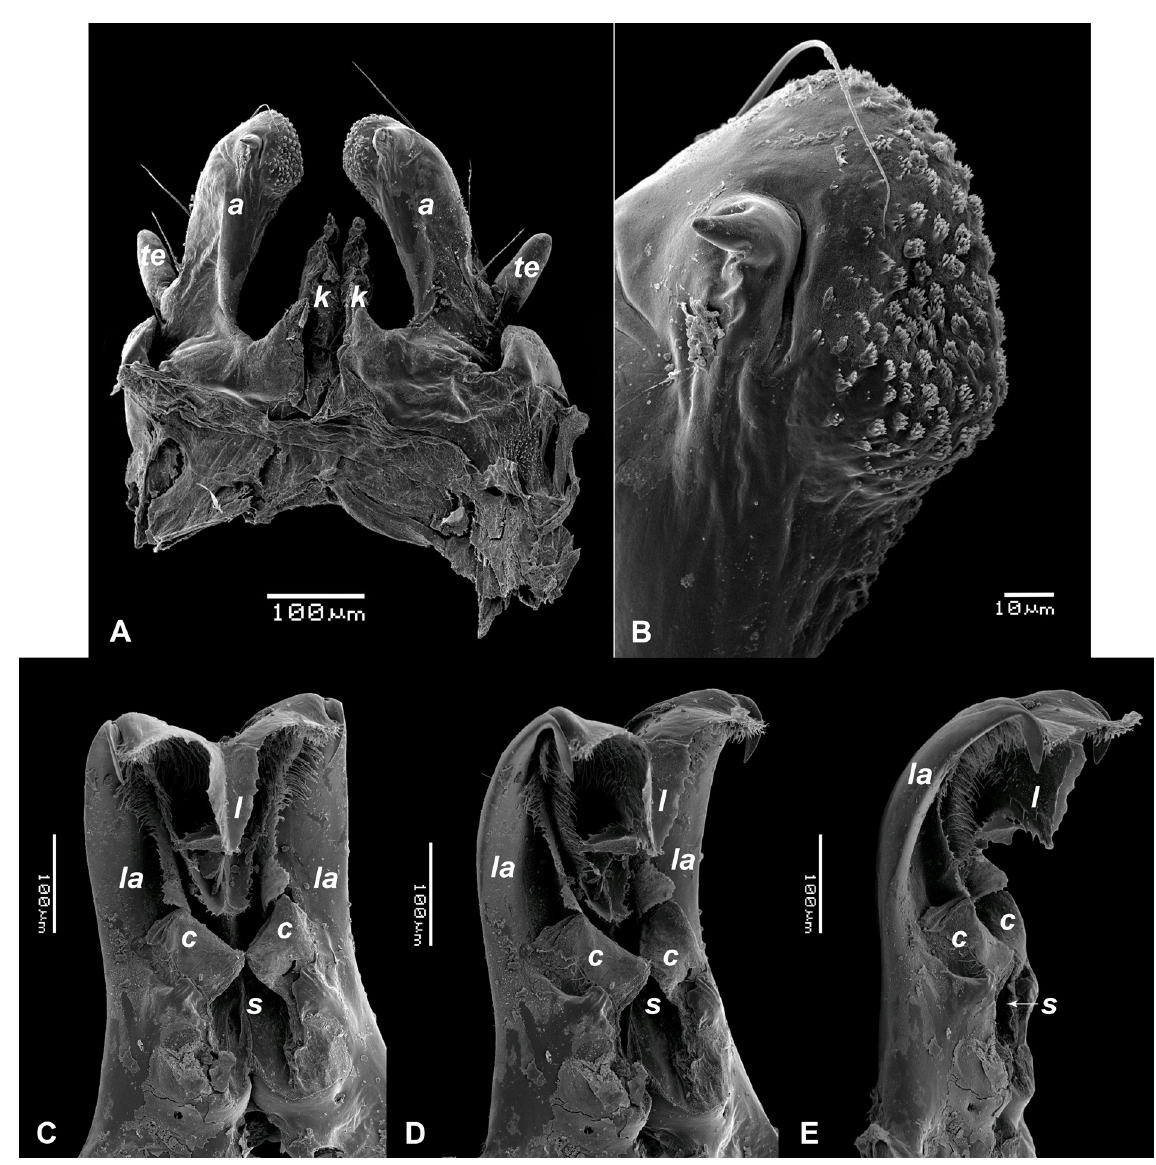
Fig. 7. Gonopods of Anamastigona terraesanctae Golovatch & Makarov, 2011, ♂, non-type from Israel, the vicinity of Binyamina. A . Posterior gonopods, frontal view. B . Apical part of left angiocoxite, frontal view. C . Anterior gonopods, caudal, slightly lateral view. D . Anterior gonopods, caudo-lateral view. E . Anterior gonopods, lateral, slightly caudal view. Abbreviations as in Fig.